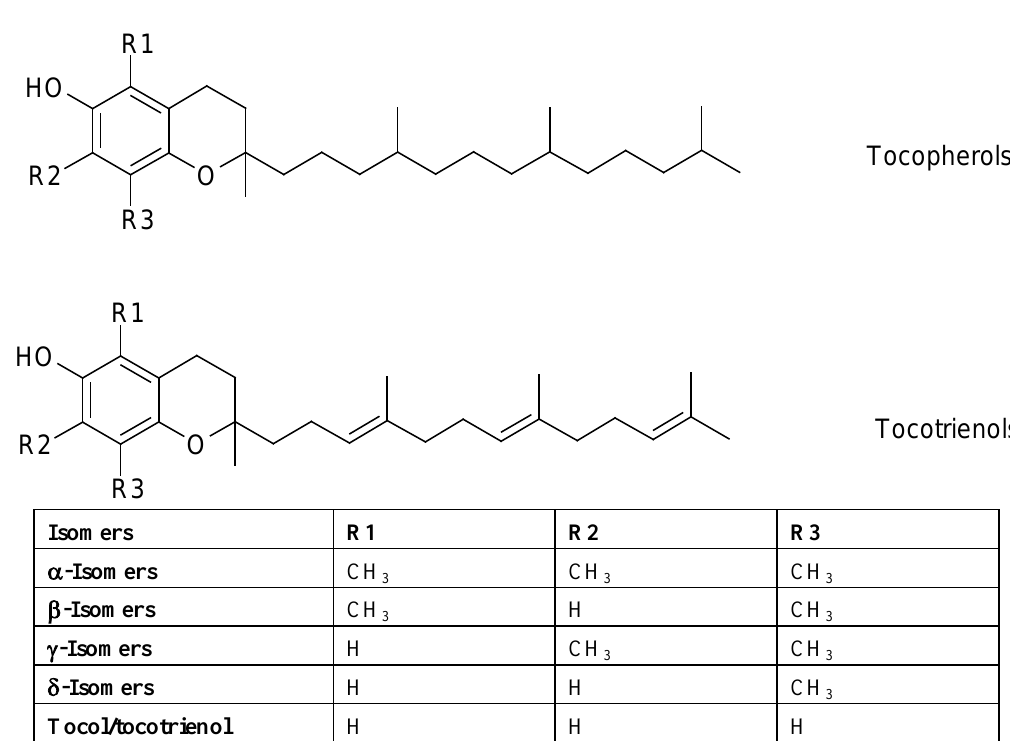
Figure 2. Structures of vitamin E